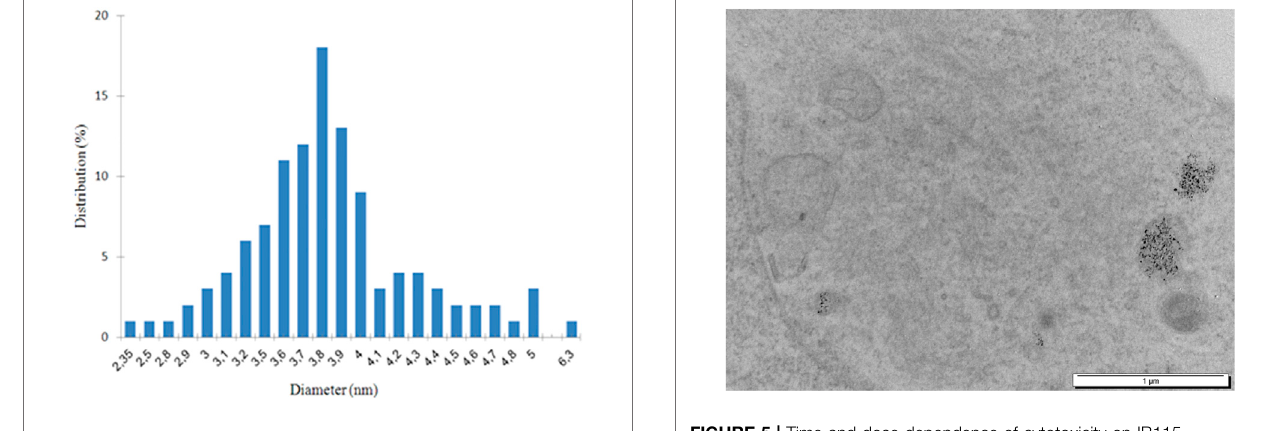
FIGURE 4 | Size distribution histogram of AuNPs.